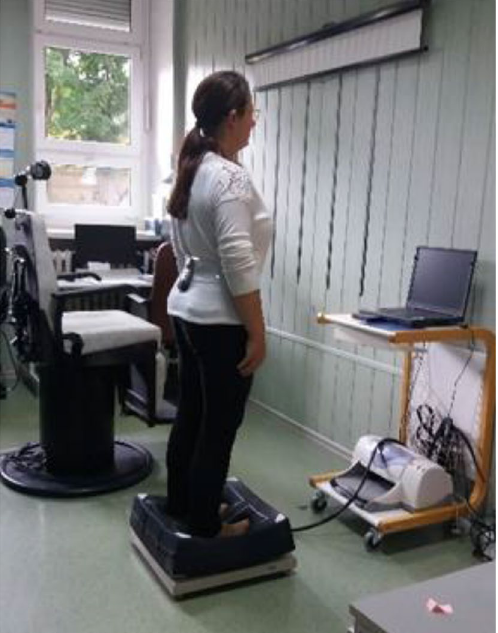
Figure 1. The 4th trial of mCTSIB protocol with head movements, which was simultaneously recorded on MediPost and the